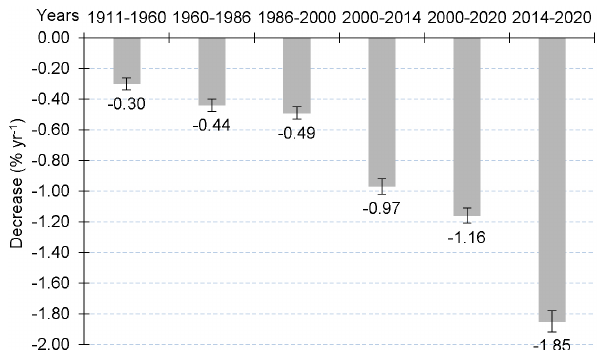
Figure 11. Comparison of glacier area decrease rates in the Greater Caucasus for six different